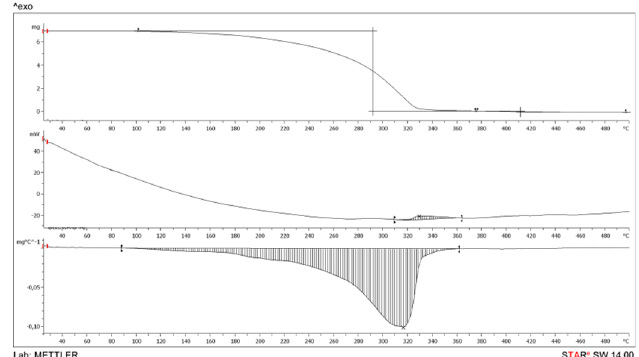
Figure 5. TGA–thermogram of the decyl phenoxyethyl adipate.